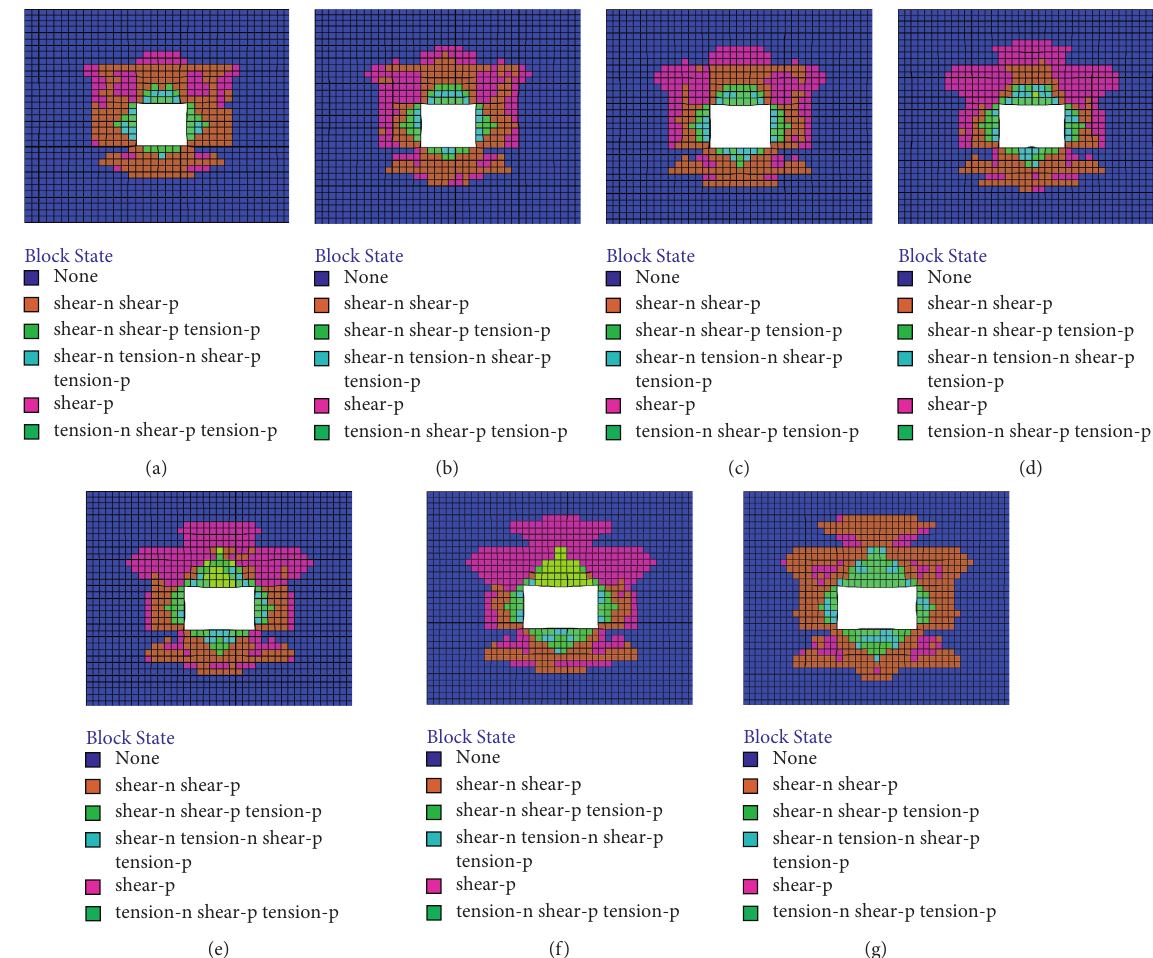
Figure 7: Distribution characteristics of plastic zone in surrounding rock of roadway with different width. (a) 3.5 m; (b) 4.0m; (c) 4.5m; (d) 5.0m; (e) 5.5m; (f) 4.0m; (g) 4.5 m; (h) legend.